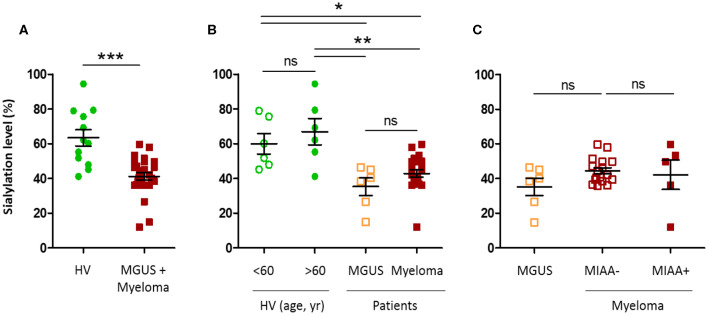
Hyposialylation of IgAs from monoclonal gammopathy of undetermined significance (MGUS) and myeloma patients. The sialylation level of IgAs in the serum of healthy volunteers (HV, n = 12), MGUS (n = 6), and myeloma (n = 22) patients was assessed using an enzyme-linked lectin assay (ELLA) technique, as described in the Materials and Methods section. Unfortunately, we were not able to constitute a control cohort of patients with excessive amounts of non-clonal IgAs. Results are expressed as percentages of sialylated forms of IgAs in serum. (A) Sialylation level of IgAs from HV (green dots) and MGUS and myeloma (MM) patients (red dots); ***p < 0.001, Mann–Whitney U-test. (B) Sialylation level according to age, in HV under or over 60 (green dots), and according to the diagnosis of MGUS (orange squares) or MM (red squares). (C) Sialylation level of IgAs from MM patients with a pathogen-specific monoclonal IgA, as determined by the MIAA (filled red squares, MIAA+) and MM patients with a monoclonal IgA of undetermined specificity (open red squares, MIAA–), compared to MGUS patients (orange squares). Bars indicate means±SEM. (B,C) Significant differences are indicated by stars; *p < 0.05 and **p < 0.01, Kruskal–Wallis test followed by Dunn's post-hoc test (ns, not significant).